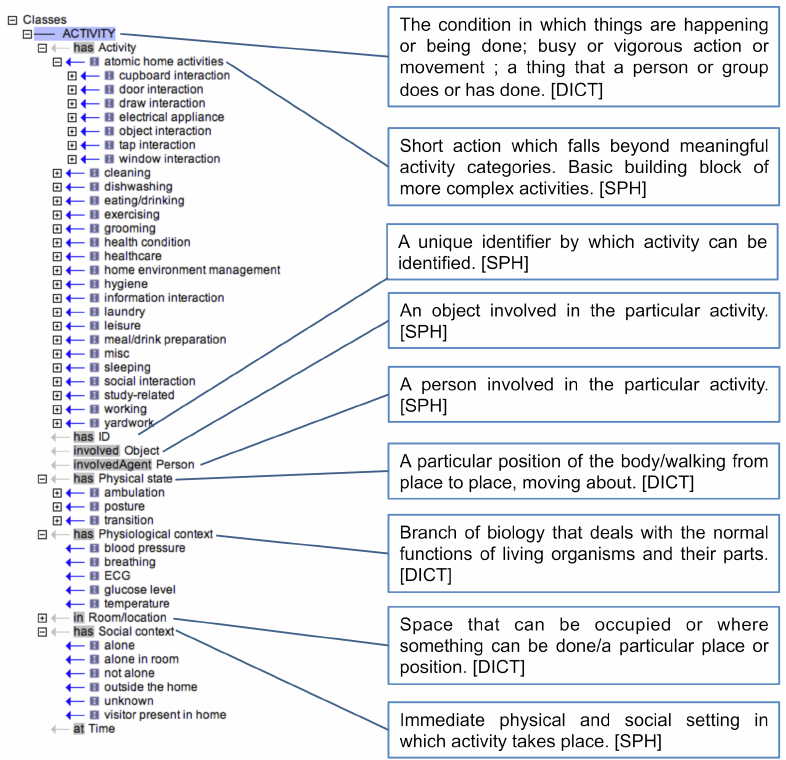
Figure 2. High-level overview of the entire ontology. The origin of each definition is indicated in square brackets. DICT is taken from a dictionary and SPH is taken from in-house